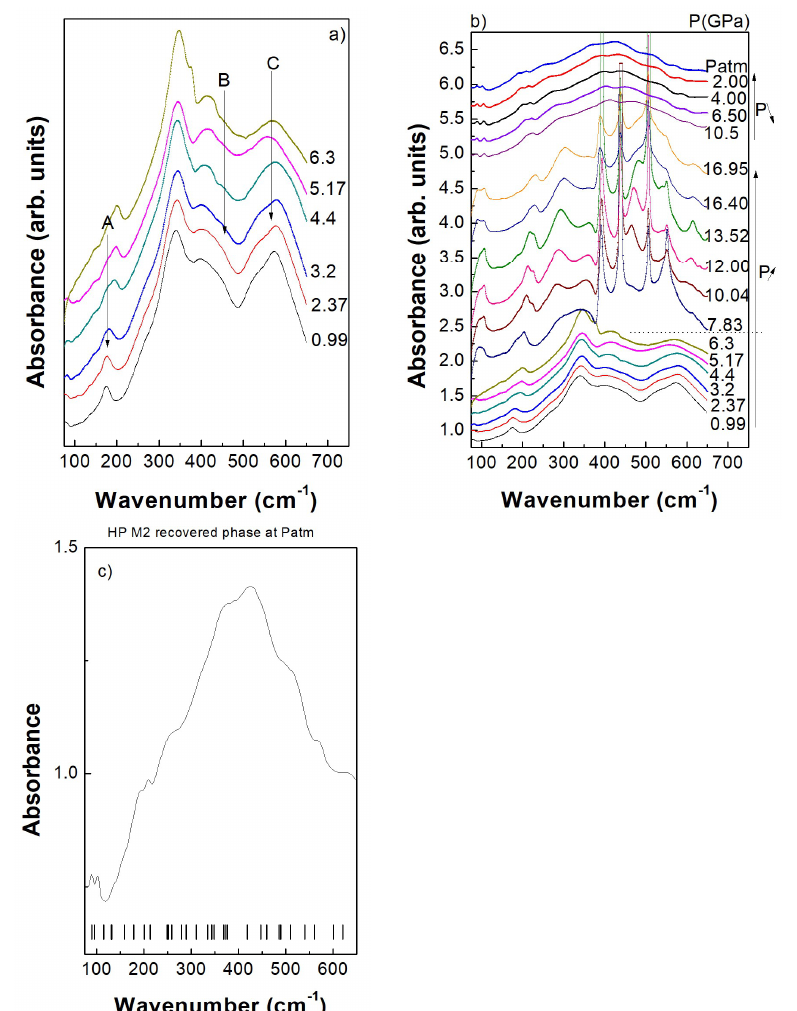
Figure 12. ( a ) Pressure dependence of the infrared spectra of LuFe 2 O 4 (vertically shifted) in the low pressure regime, i.e., within the M1 phase stability range; A,B,C correspond to the labelled infrared modes which could be associated to a phase transition as previously observed based on diffraction techniques ( b ) vertically shifted infrared spectra during compression-decompression; the dotted line marks the transition to the M2 phase; ( c ) high-pressure M2 phase recovered at ambient pressure; vertical ticks represent calculated optical infrared modes. Note on Figure 10c that the frequency positions of the calculated infrared modes are upshifted as they were determined at 0 K whereas the experimental spectra are obtained at room temperature.